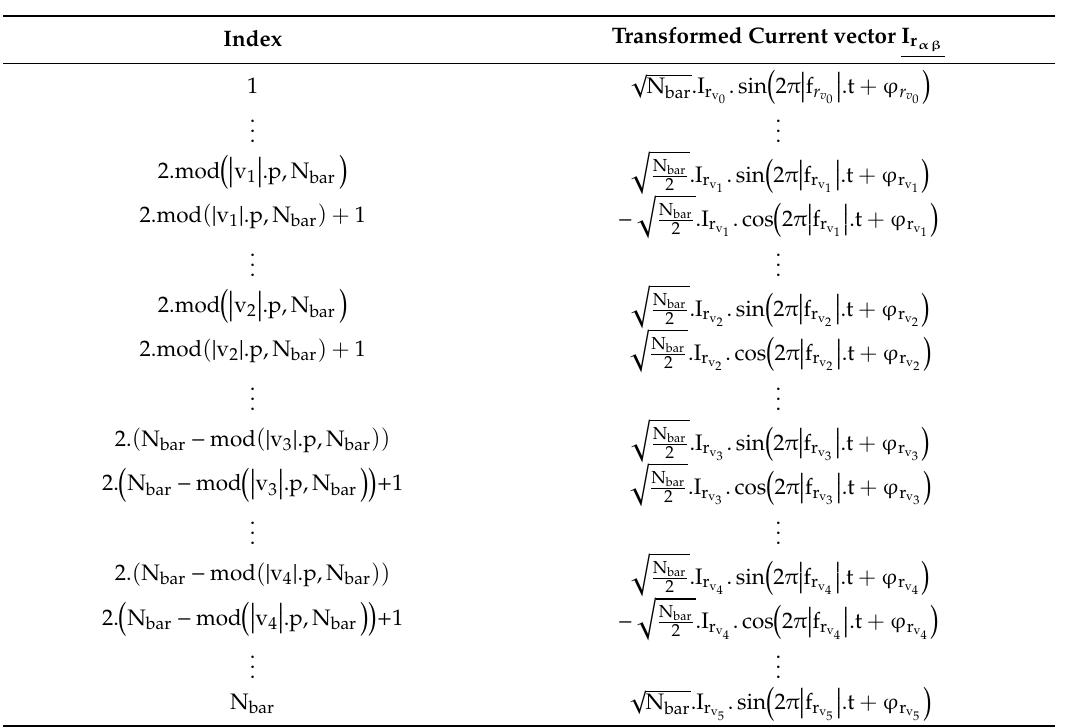
Table 2. Transformed rotor current vector I r